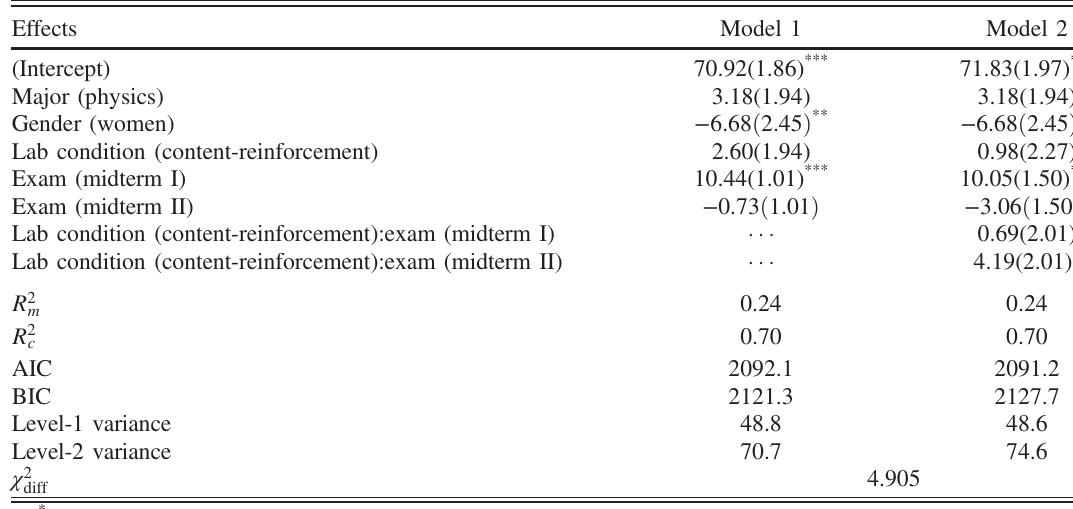
TABLE III. Mixed model analysis of students ’ exam performance generated by the lme4 package [48] in R [49]. All exams are scored out of 100. Students who do not have scores for all exams are removed from the analysis; there are 95 participants in this analysis. The reference group is exam (final), major (nonphysics), gender (men), and lab condition (experimentation). Though p values and R 2 are ill defined for mixed models, we report estimates. Statistical significance is calculated by the lmer T est package [50], and marginal and conditional R 2 are calculated using the M u MI n package [51].